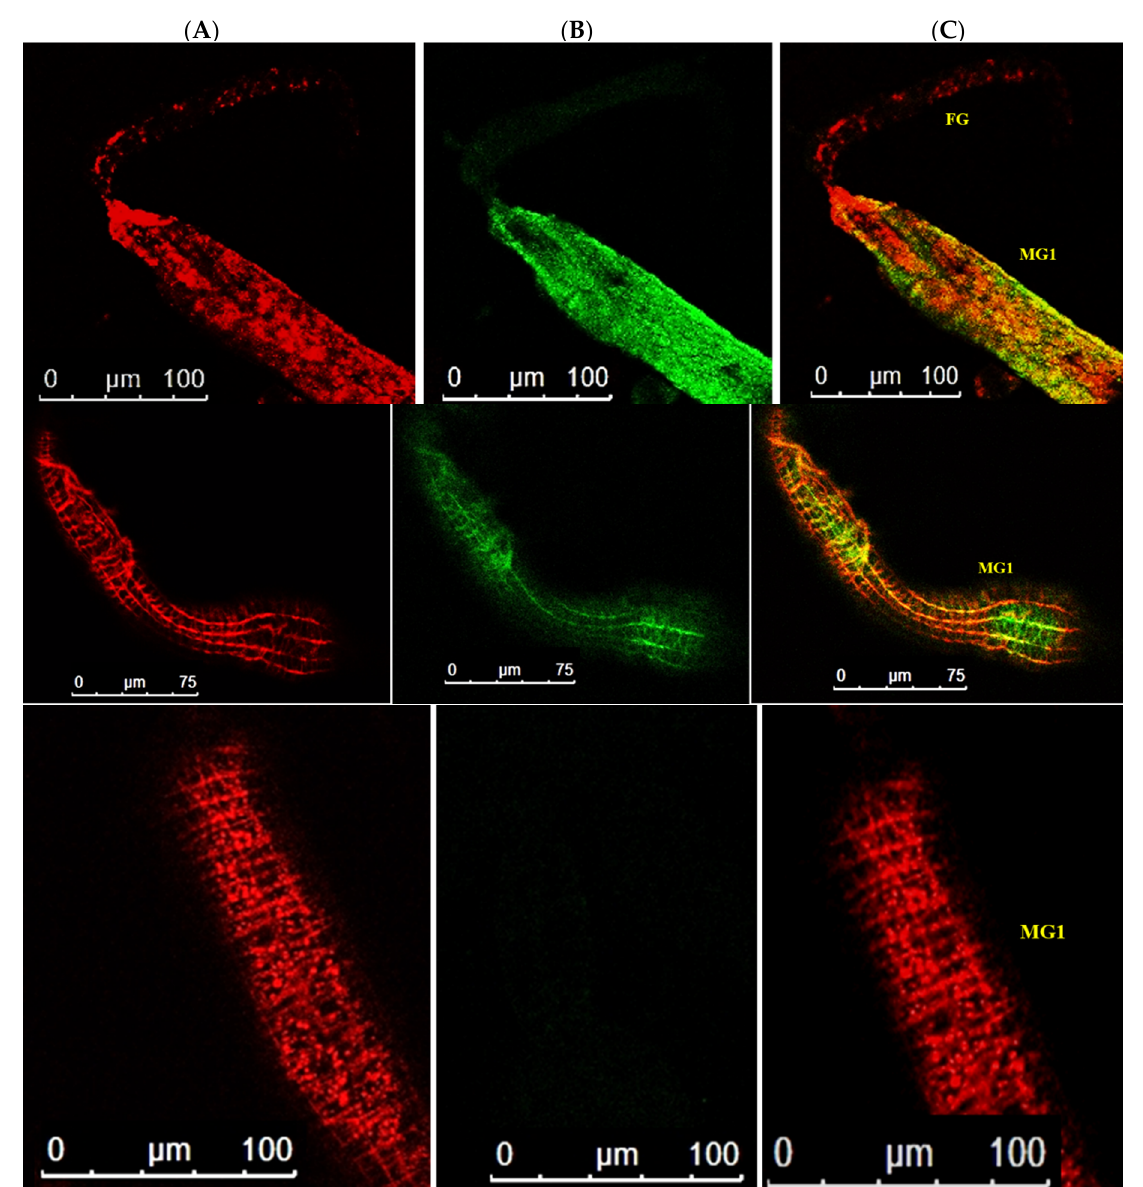
Figure 9. Accumulation of WBNV in anterior midgut of Thrips palmi adult. ( A ). Alexa Fluor 594 phalloidin-conjugated F-actin probe red fluorescence ( B ). FITC-conjugated goat anti-rabbit secondary antibody green fluorescence indicating WBNV-N protein ( C ). Merged image of red and green fluorescence signals. FG—foregut; MG1—midgut 1. Level of WBNV infection was highest in anterior midgut (top panel). Green fluorescence indicating WBNV N protein increased in midgut 12 days post acquisition. Infection of longitudinal and circular muscle cells of the midgut was evident by presence of green fluorescence (middle panel). No FITC green fluorescence was observed in the midgut of aviruliferous T. palmi (bottom panel).